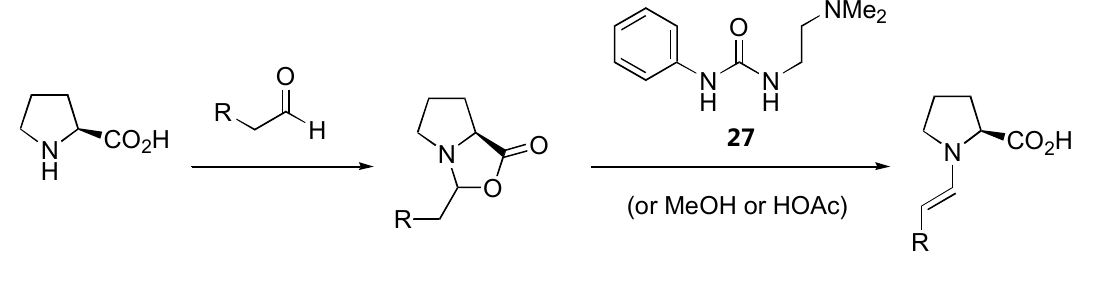
Figure 20. The involvement of urea 27 in accelerating the rate of proline-catalyzed aminoxylation [77].